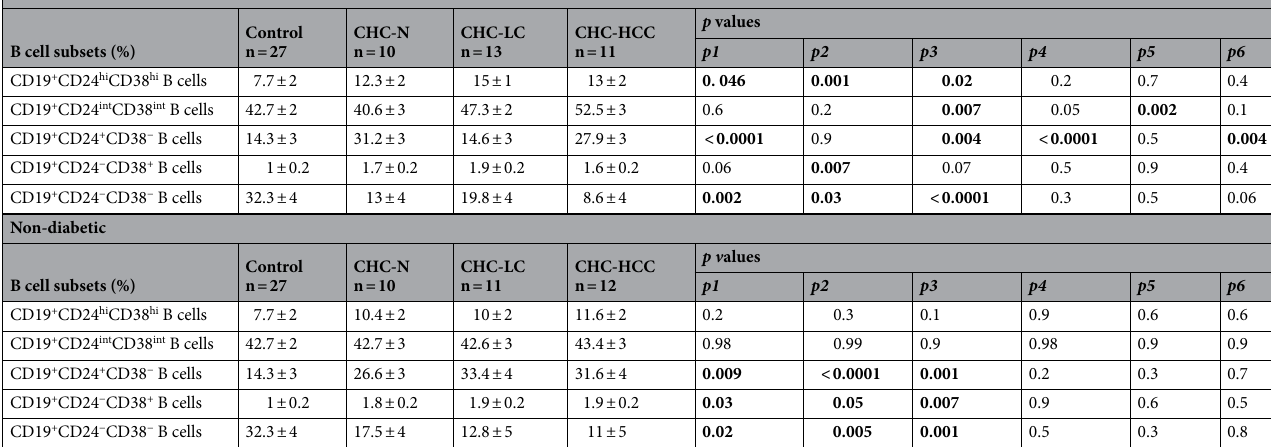
Table 4. CD19 + B cell subsets in chronic hepatitis C patients with different degrees of liver affection in relation to diabetes mellitus. (%) the percentage was calculated from CD19 + B cells. CHC-N chronic hepatitis C with no cirrhosis or hepatocellular carcinoma, CHC-LC chronic hepatitis C with liver cirrhosis, CHC-HCC chronic hepatitis C with hepatocellular carcinoma. Results expressed as mean ± standard error. Multivariate analysis of covariance (MANCOVA) with age and sex as covariates, Significant p -value is < 0.05 (bold). p 1: CHC-N vs. Control p 2: CHC-LC vs. Control p 3: CHC-HCC vs. Control. p 4: CHC-N vs. CHC-LC p 5: CHC-N vs. CHC- HCC p 6: CHC-LC vs.